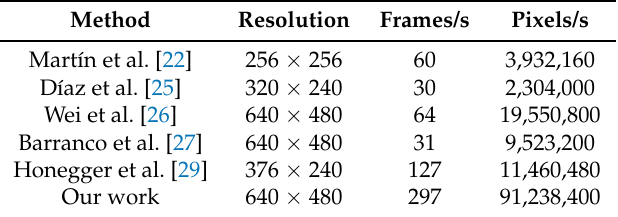
Table 4. Processing speed